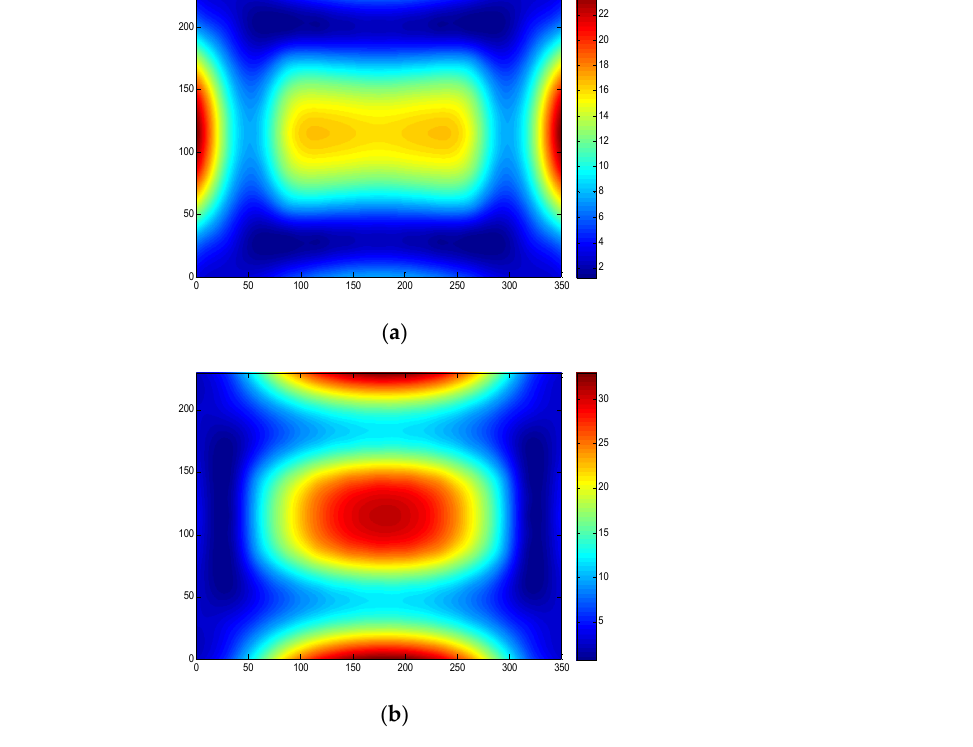
Figure 11. The RMS of the panel at 162 dB and 600 °C. ( a ) The RMS in the direction of the length of the panel; ( b ) The RMS in the direction of the width of the panel.